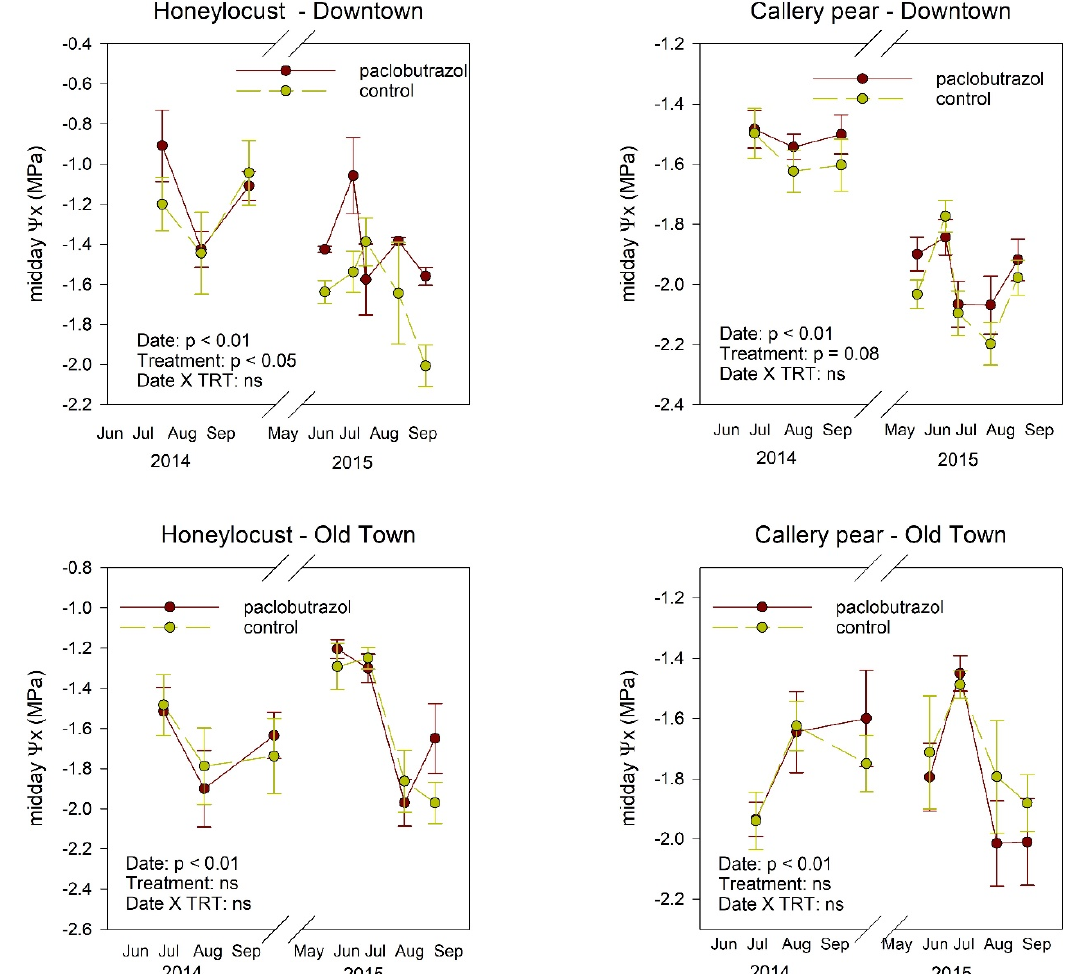
Figure 3. Mean midday leaf water potential ( Ψ w) of honeylocust and Callery pear trees at two locations in Lansing, MI USA in 2014 and 2015. Trees were treated with paclobutrazol in 2013 (paclobutrazol) or not treated (control). Error bars indicate standard error of the mean.